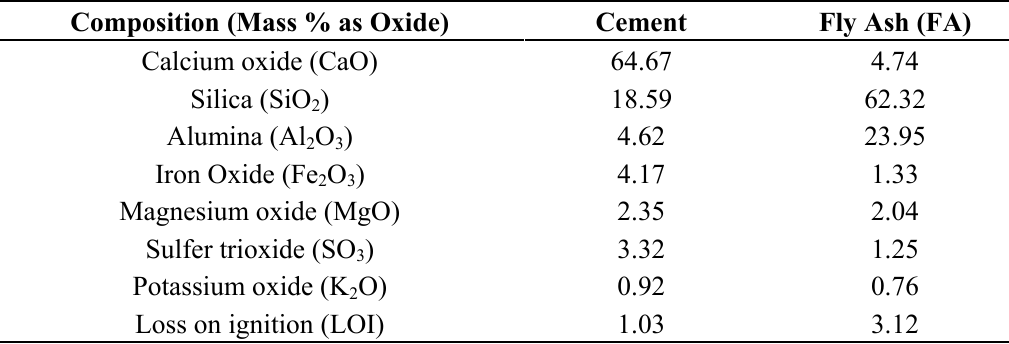
Table 1. Chemical compositions of cement and fly ash.